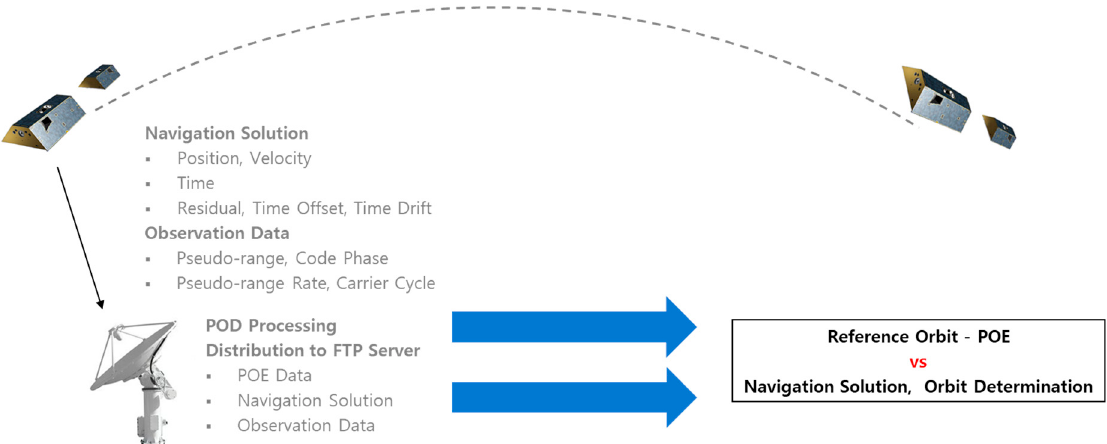
Figure 8. Evolution of complexity in Earth gravity models [13].